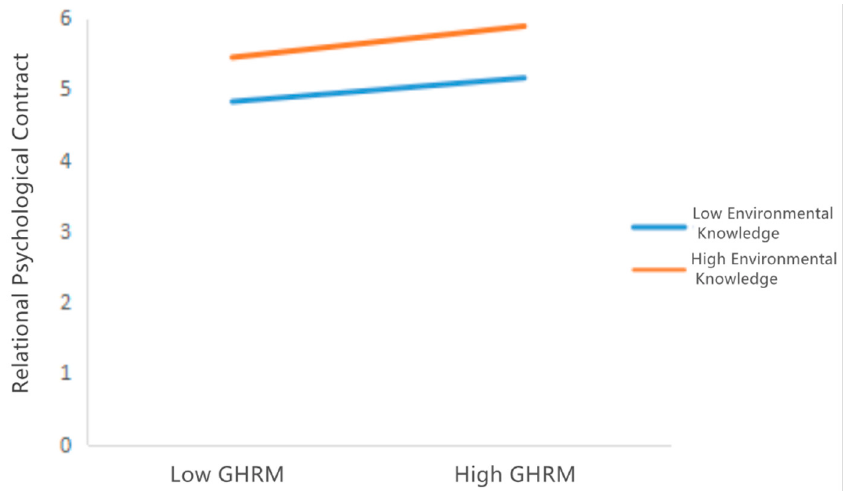
Figure 2. Mediating effects of environmental knowledge between GHRM and relational psychologi- cal contracts.